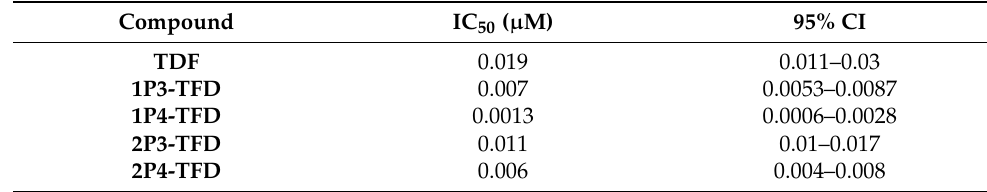
Table 2. Antiviral activity of TDF and mPEG-b-PEPA adducts of TFD 1 .